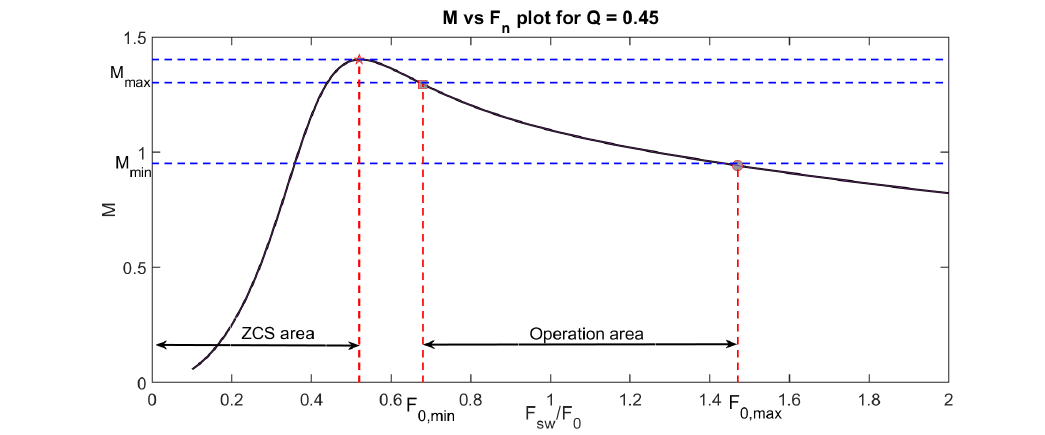
Figure 10. Gain curve for m = 6 and Q =